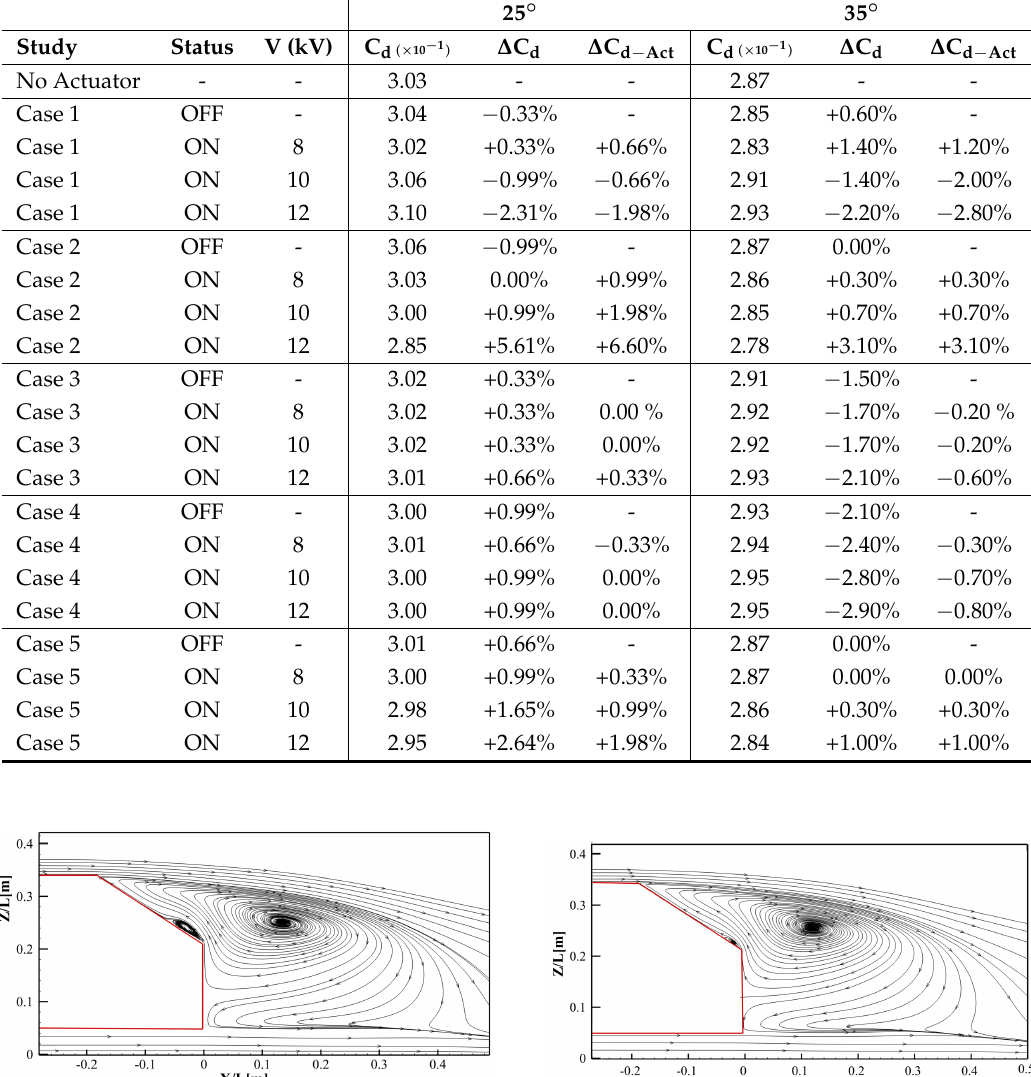
Table 5. Numerical results at a frequency of 4.5 kHz and at Re = 2.25 × 10 5 for an Ahmed body with a slant angle of 25 ◦ . Here, ∆ C d denotes the drag reduction, and ∆ C d − Act denotes the actuator drag reduction ( + sign indicate reduced drag).